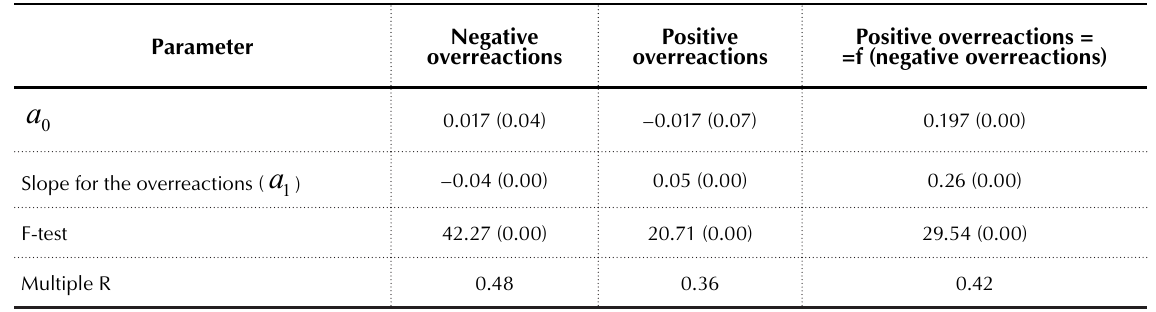
Table 7. Additional regression analysis